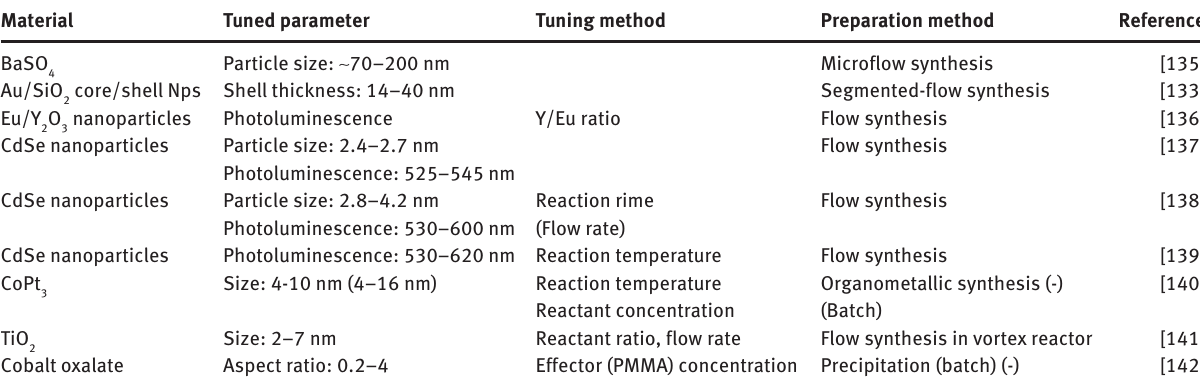
Table 2 Parameter tuning of compound semiconductors, magnetic, and oxidic materials, mainly prepared by micro-continuous flow synthesis.